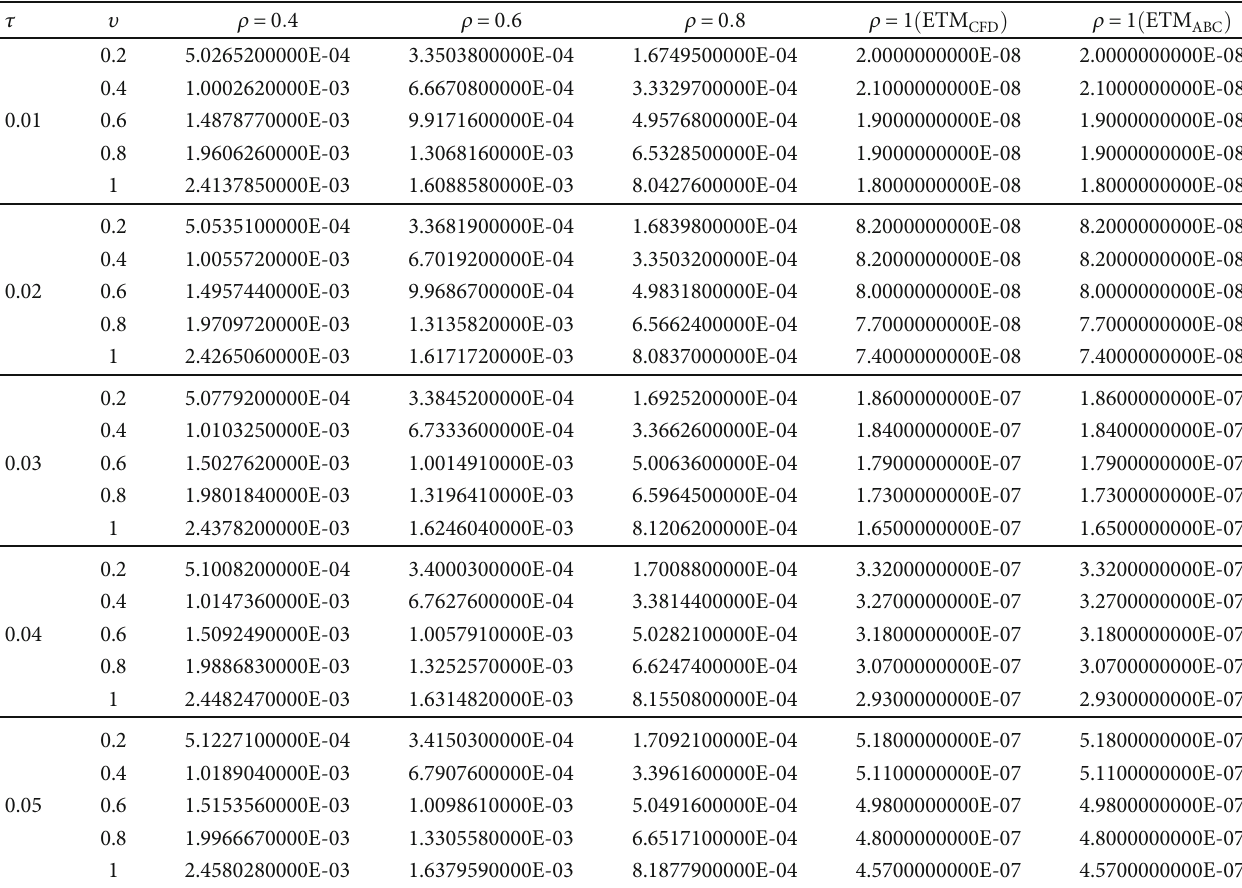
Table 2: Comparison of absolute errors of proposed method solution at various fractional-orders with c = 0 : 5 for problem